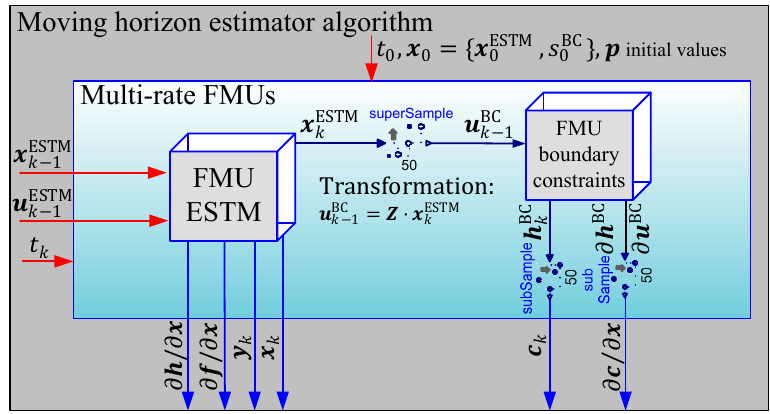
Figure 10. Two encapsulated multi-rate functional mockup units (FMUs) as one prediction model.